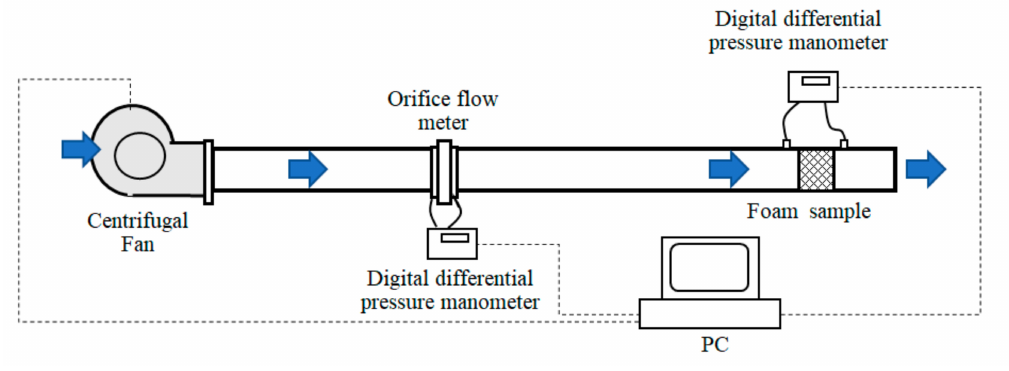
Figure 1. Lay-out of the experimental